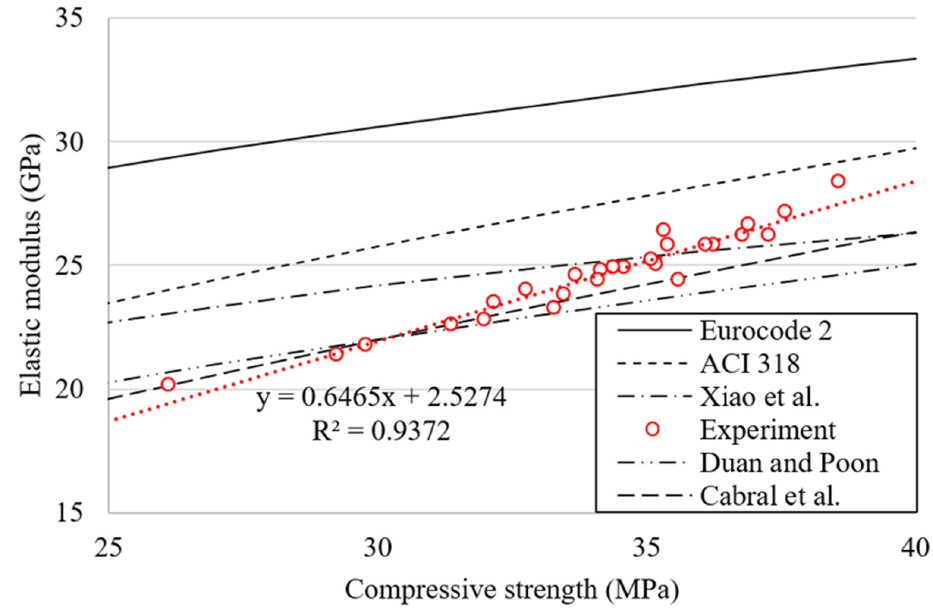
Figure 12. Correlation between compressive strength and elastic modulus.